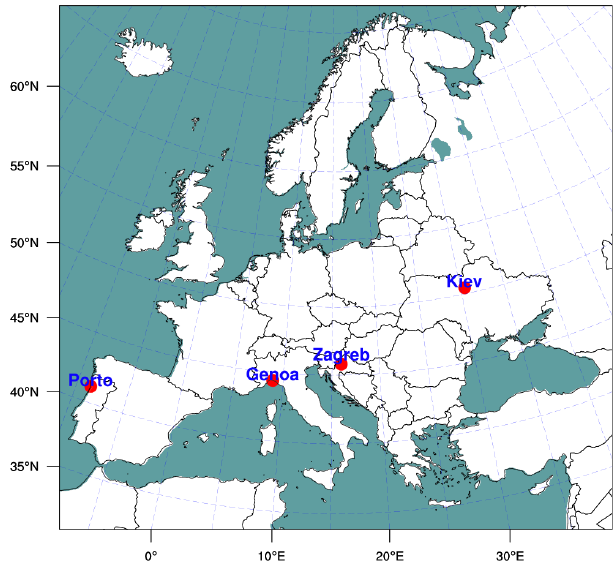
Figure 2. The numerical domain of the WRF-Chem simula- tions with 380 × 360 grid points and 12km grid cells as well as the location of the four cities in Europe selected for analyzing the sim- ulated isoprene and α -pinene emissions, namely Porto (Portugal), Genoa, (Italy), Zagreb, (Croatia), and Kyiv, (Ukraine), spanning the range 41.15–51.45 ◦ N and 8.63 ◦ W–30.50 ◦